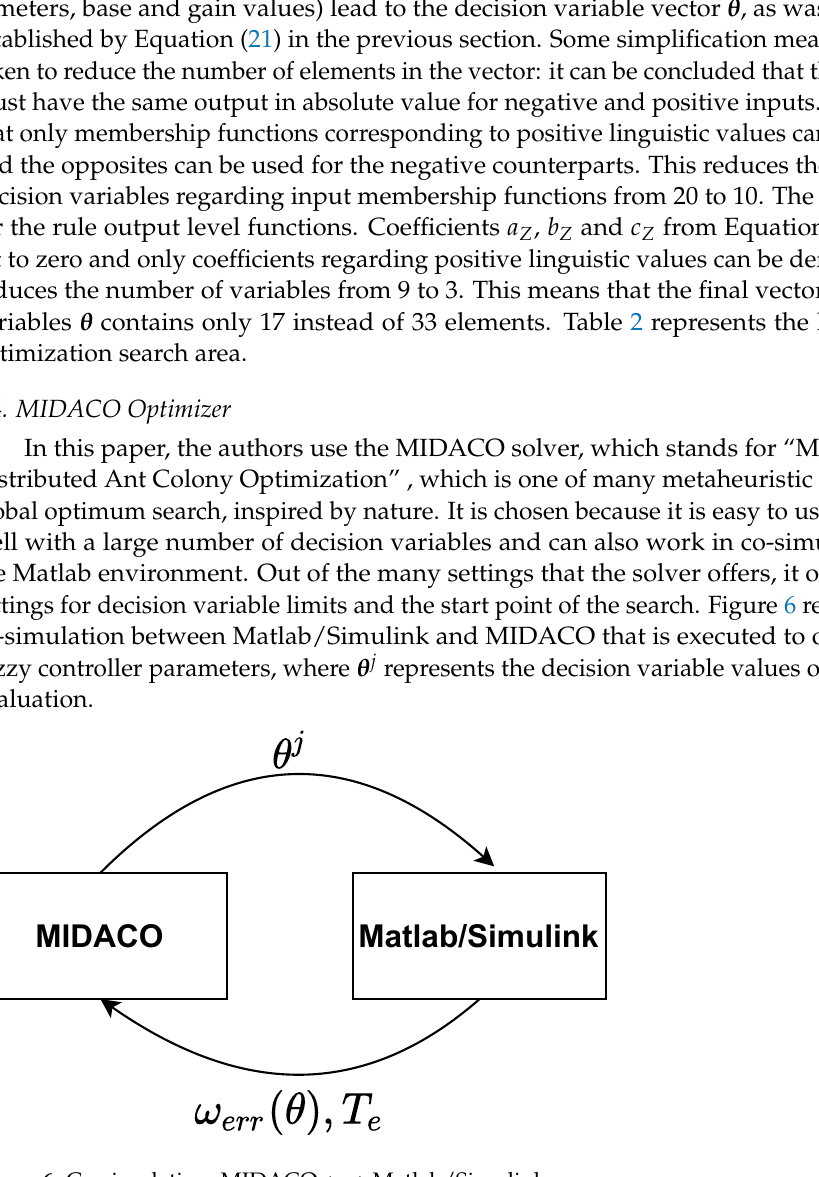
Figure 6. Co-simulation: MIDACO ←→